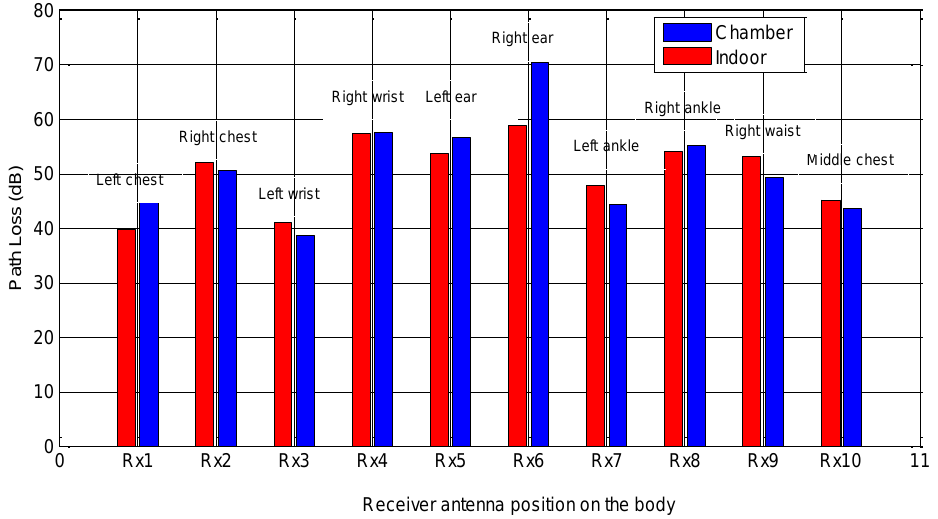
Figure 12. Comparison of path loss for left waist to 10 different on-body links at 2.45 GHz, measured in the chamber and in an indoor environment, of the dual band